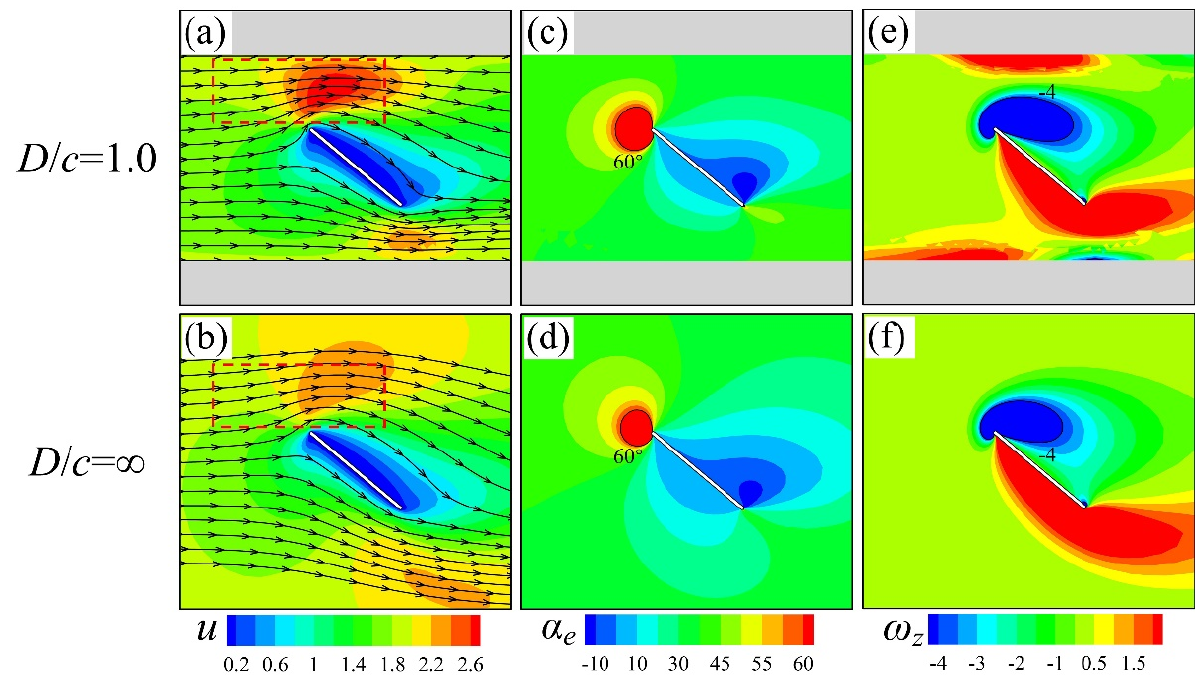
Figure 9. The streamlines and velocity ( u ) contours relative to the wings ( a , b ), the effective angle of attack ( α e ) contours ( c , d ), and the spanwise vorticity ( ω z ) contours ( e , f ) in the middle of the first downstroke ( τ = 0.25) at Re = 10. The first row is for D / c = 1.0, and second row is for D / c = ∞